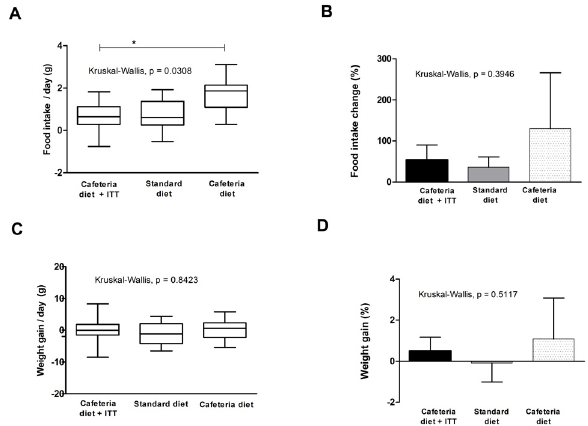
Figure 2. Food intake and weight gain in Wistar rats with obesity-based MetS submitted to different treatments: Cafeteria diet + TTI (cafeteria diet + 1 mL of gavage TTI at 25 mg/Kg); Standard diet (Labina ® diet + 1 mL of gavage water); Cafeteria diet (cafeteria diet + 1 mL of gavage water). All groups represent experiments with n = 5 animals. ( A ) Daily differences in food intake (g) box plots of study groups; ( B ) total food intake change (%) in studied groups; ( C ) daily weight gain (g) box plots of study groups; and ( D ) total weight gain (%) in studied groups. * Statistical difference between groups, with Dunn’s post-hoc test p < 0.05. TTI: Tamarindo seed Trypsin Inhibitor.